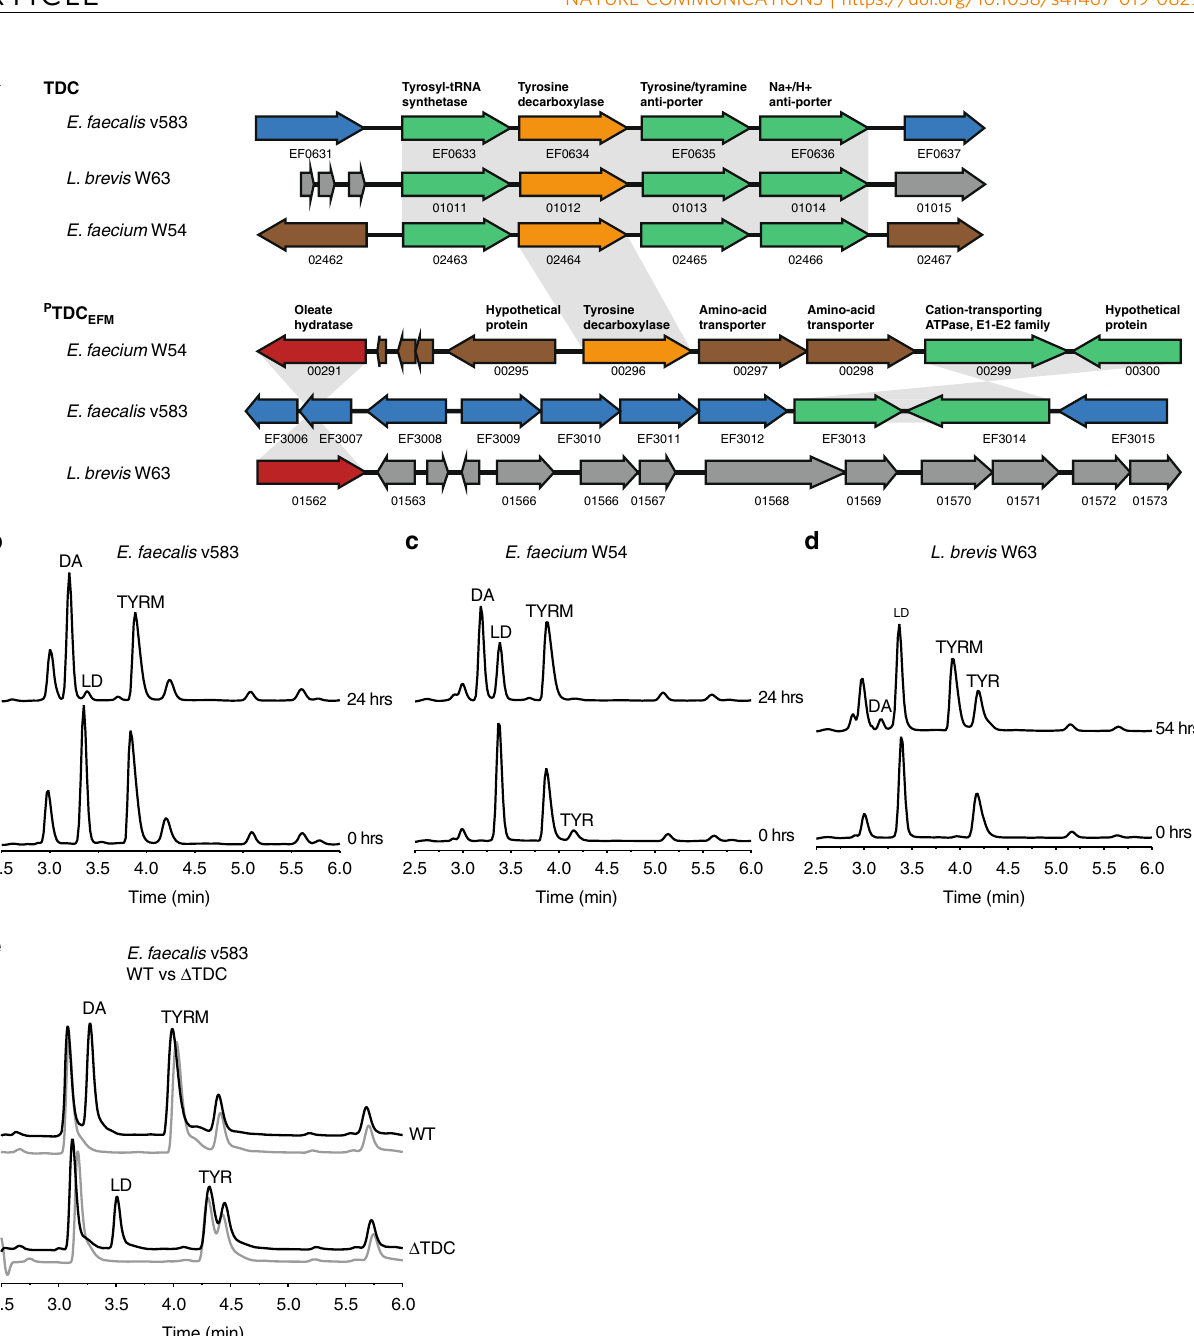
Fig. 2 Gut bacteria harboring tyrosine decarboxylases are responsible for levodopa decarboxylation. a Aligned genomes of E. faecium , E. faecalis , and L. brevis . The conserved tdc -operon is depicted with tdc gene in orange. Overnight cultures of b E. faecalis v583, c E. faecium W54, and d L. brevis W63 incubated anaerobically at 37 °C with 100 µ M of levodopa (LD). e Overnight cultures of EFS WT and EFS Δ TDC incubated anaerobically at 37 °C with 100 μ M levodopa (black line) compared to control (gray line) where no levodopa was added. Curves represent one example of three biological